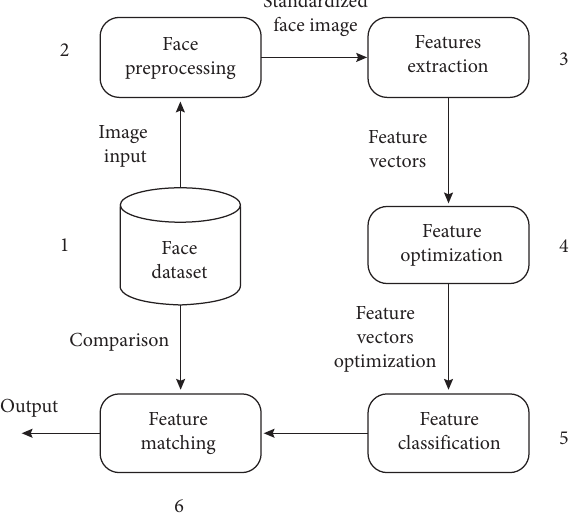
Figure 1: Implementation pipeline.